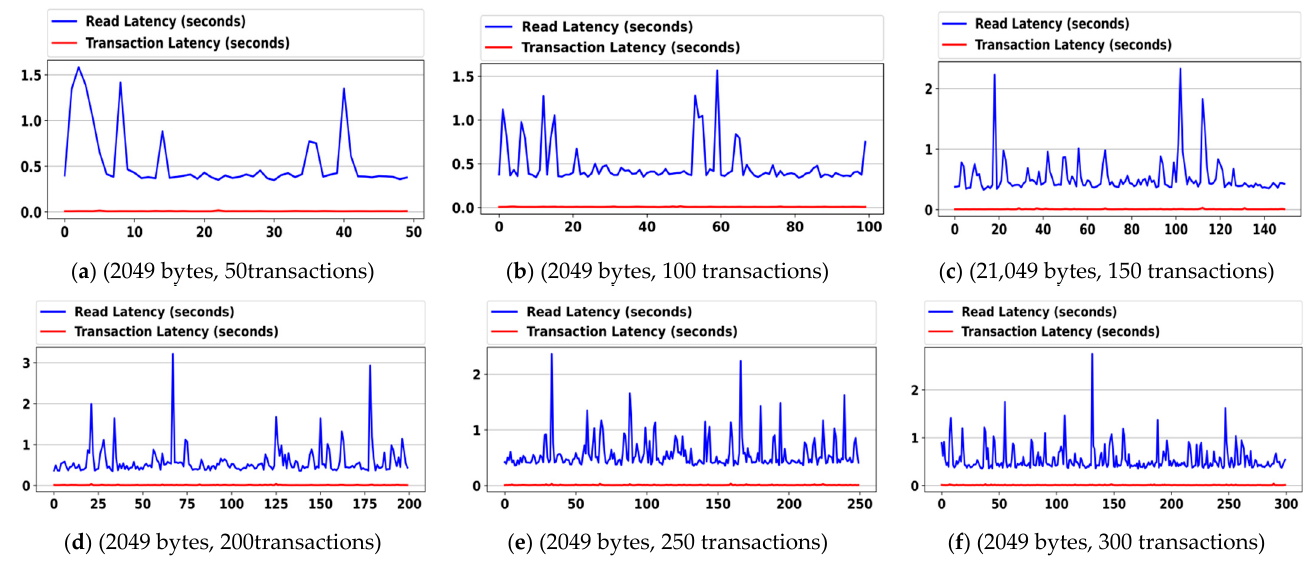
Figure 5. Impact of the transactional data size,2049 bytes on RL, and TL for ( a ) 50, ( b ) 100, ( c ) 150, ( d ) 200, ( e ) 250, and ( f ) 300 transactions.